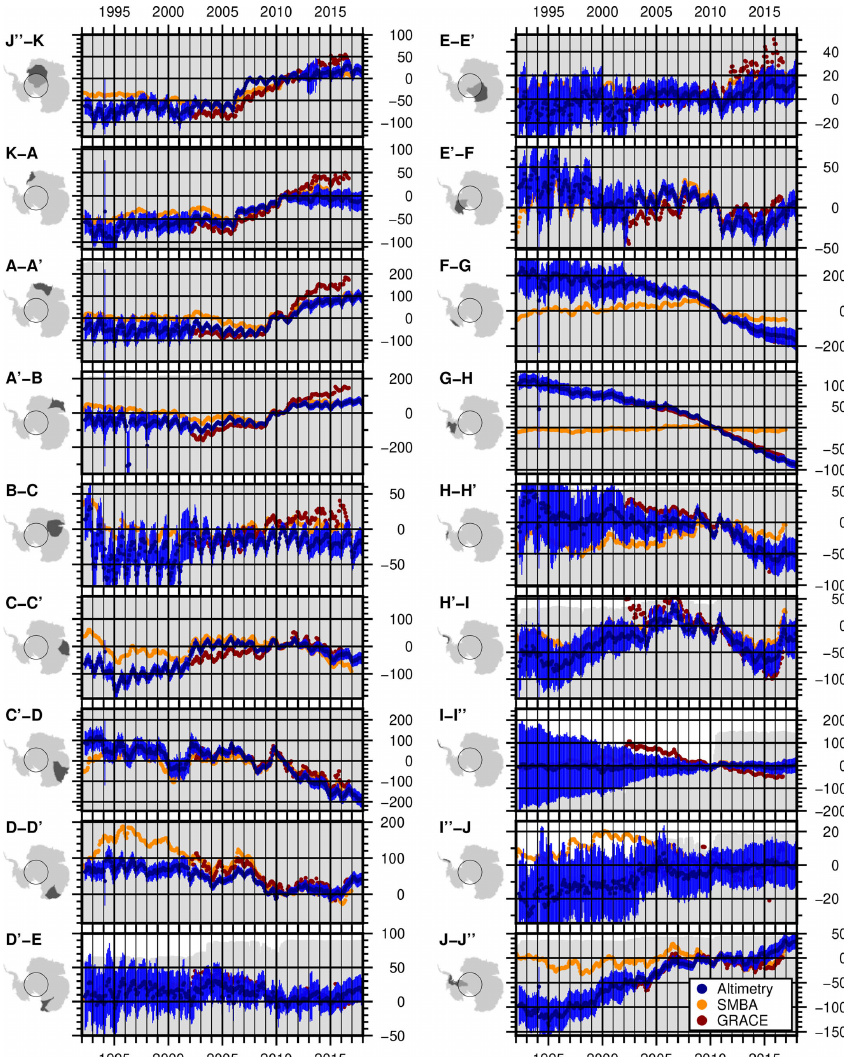
Figure 12. Mass change ( (cid:49)M [Gt]) of the individual drainage basins north of 81.5 ◦ S from our combined altimetric time series (blue), GRACE (red) and SMBA (orange). The error bars show the uncertainty estimate σ (cid:54) of the altimetry data according to Sect. S6.2. The gray color in the background displays the fraction of the area covered by altimetry (the top of each panel means